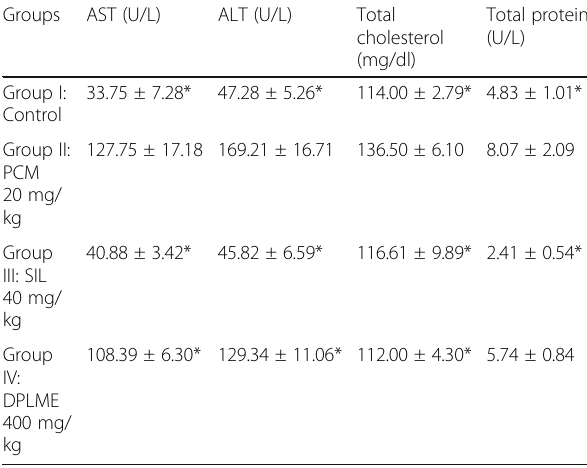
Table 3 Effect of methanolic leaf extract of D. pentandra on key liver function parameters of Rats having PCM induced